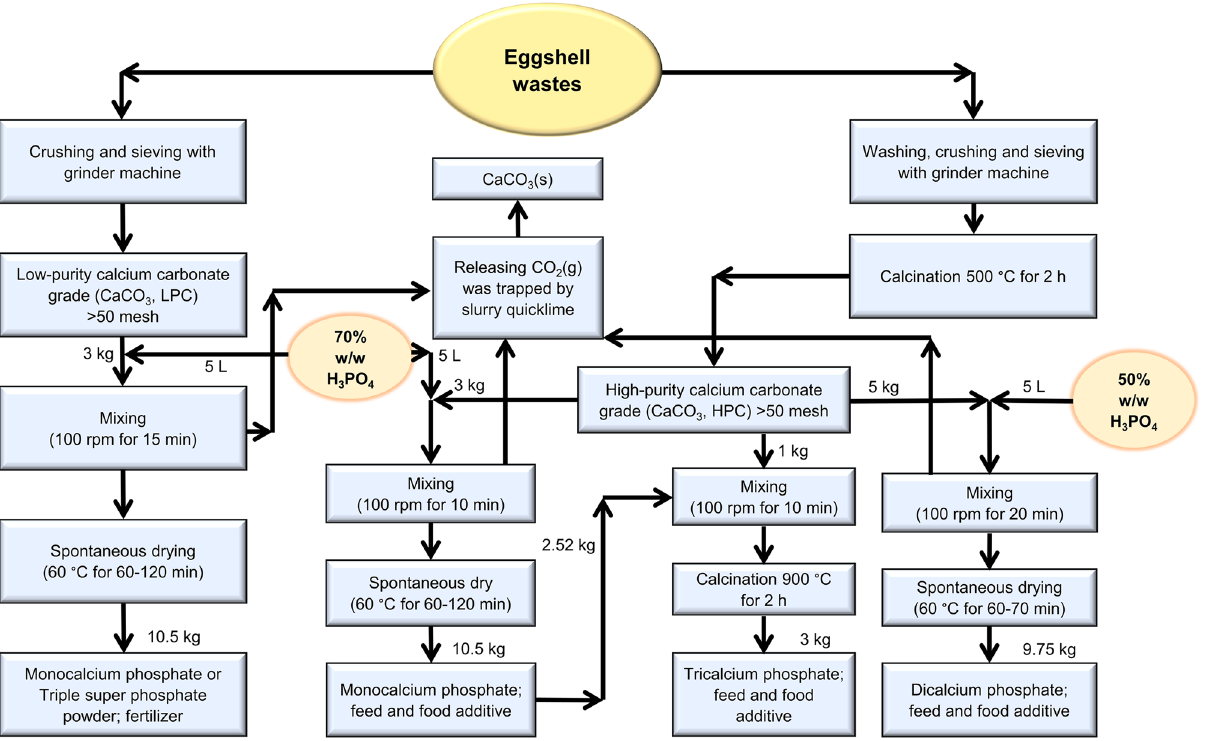
Figure 1. Process flowchart of low- and high-purity calcium carbonates obtained from eggshells and four calcium phosphate